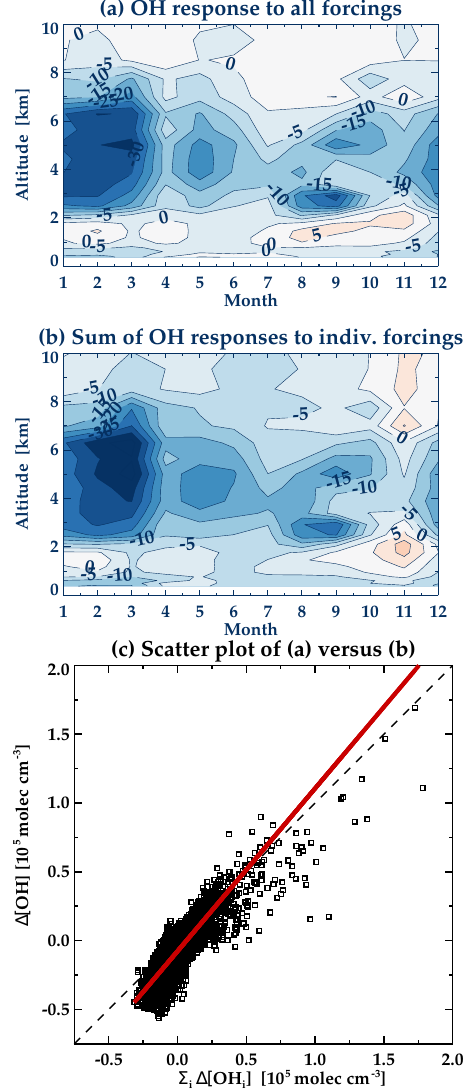
Figure 9. (a) Multi-annual and monthly-mean percentage differ- ence in OH between a simulation with bias correction applied to all five fields and the reference simulation. Radiosonde H 2 O is as- sumed below 8km. (b) Summation of all the single forcing contri- butions as expressed by the right hand side of Eq. (4). Radiosonde H 2 O is assumed below 8km. (c) Scatter plot of the response of OH to the combination of all forcings (vertical axis, denoted as (cid:49) [ OH ] ) vs. the summation of the OH response to individual forcings (hori- zontal axis) as expressed by the right hand side of Eq. (4) (denoted (cid:49) [ OH i ] ). The red solid line denotes an orthogonal fit. The by P i black dashed line is the